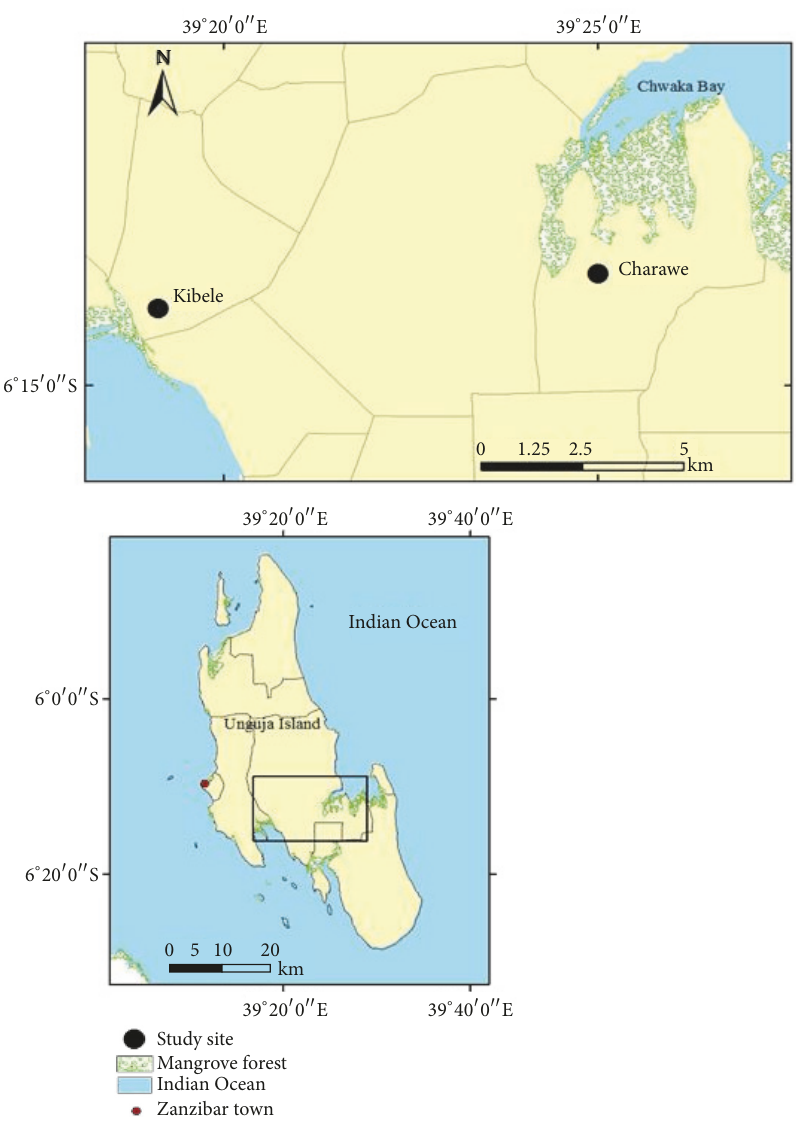
Figure 1: Unguja map showing the study sites (Source IMS